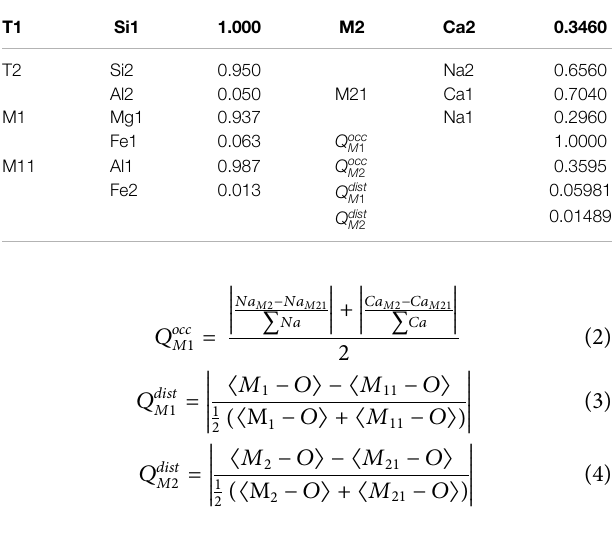
TABLE 5 | Site populations and degree of order for